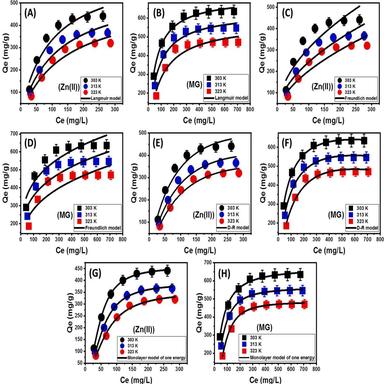
Fitting of the experimental data for the adsorption of Zn2+ ions and MG dye onto Mg.HAPNFs using the (A) and (B) Langmuir, (C) and (D) Freundlich, (E) and (F) Dubinin–Radushkevich, and (G) and (H) monolayer model with one energy site.